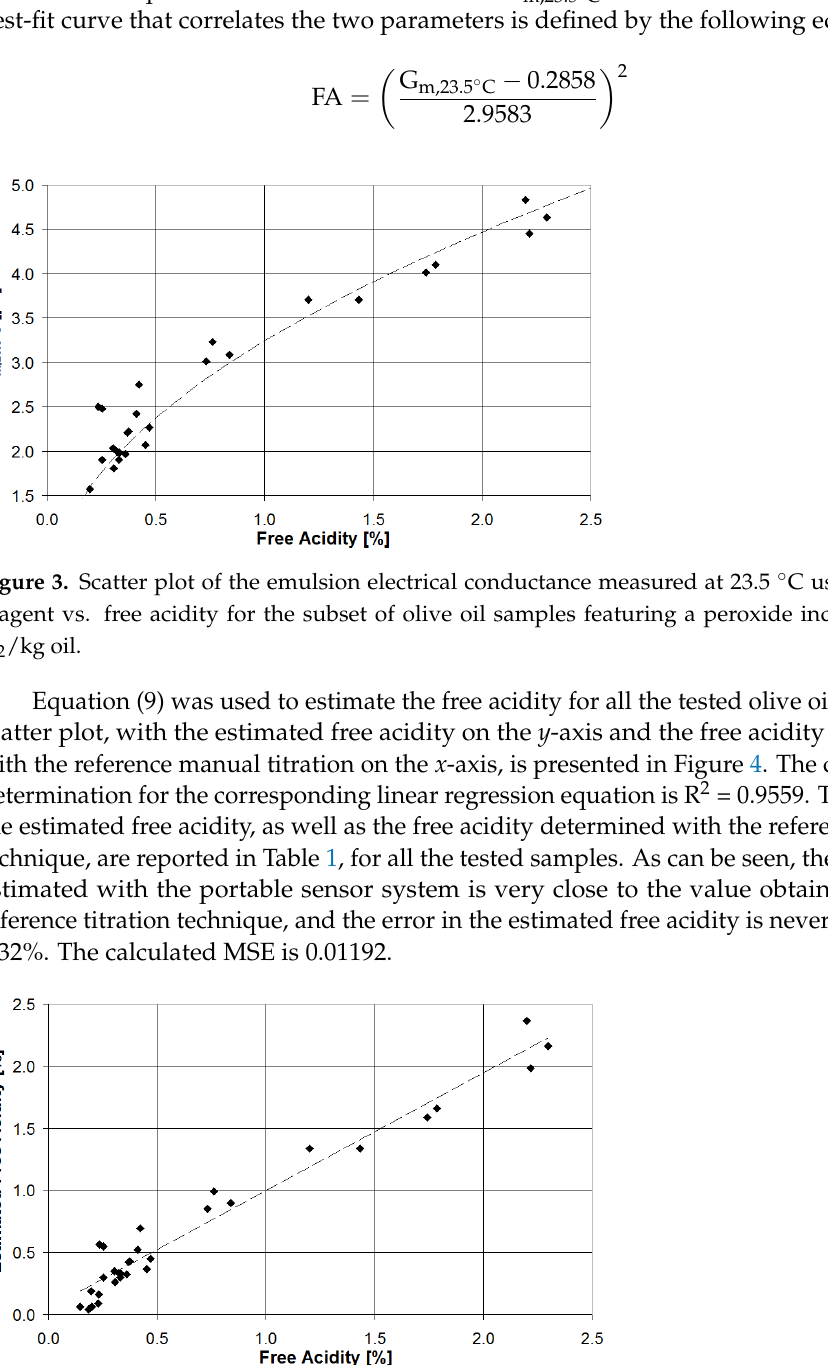
Figure 4. Scatter plot of the free acidity estimated with the portable sensor system vs. the free acidity obtained with the reference manual titration for the subset of olive oil samples featuring a peroxide index < 20 meq O 2 /kg